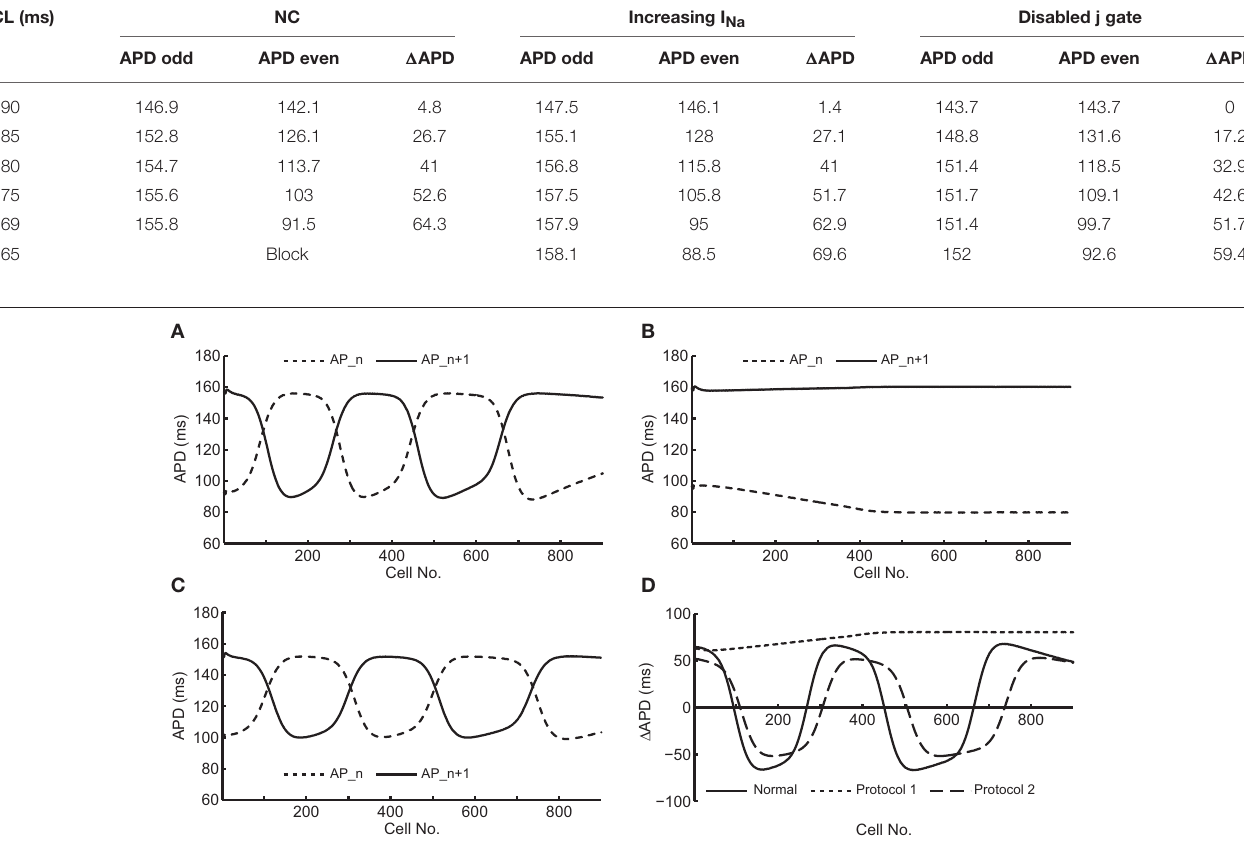
TABLE 1 | Summary of APDs (in milliseconds) during normal conduction (NC) and SNCs at different CL. CL (ms)